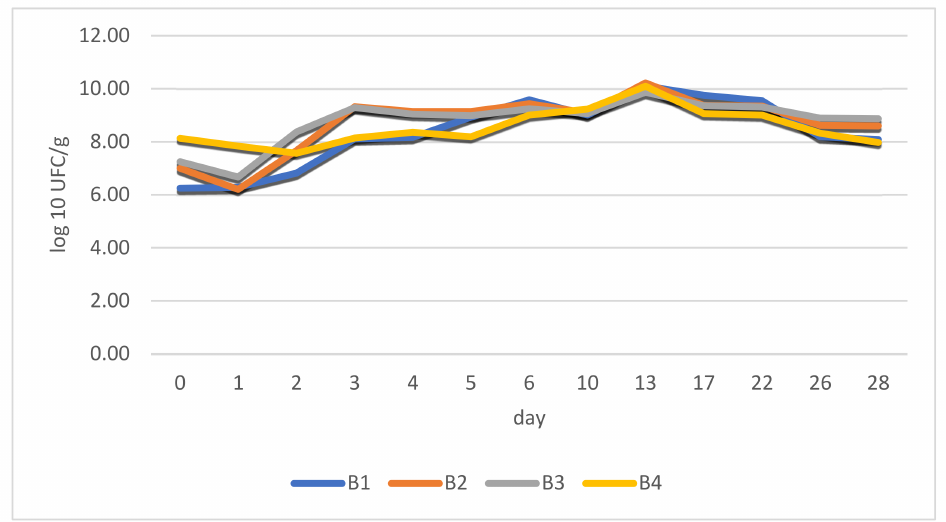
Figure 5. Total viable count during a 28-day fermentation period in the case of four batches of fermented salami with different sources of fermenting